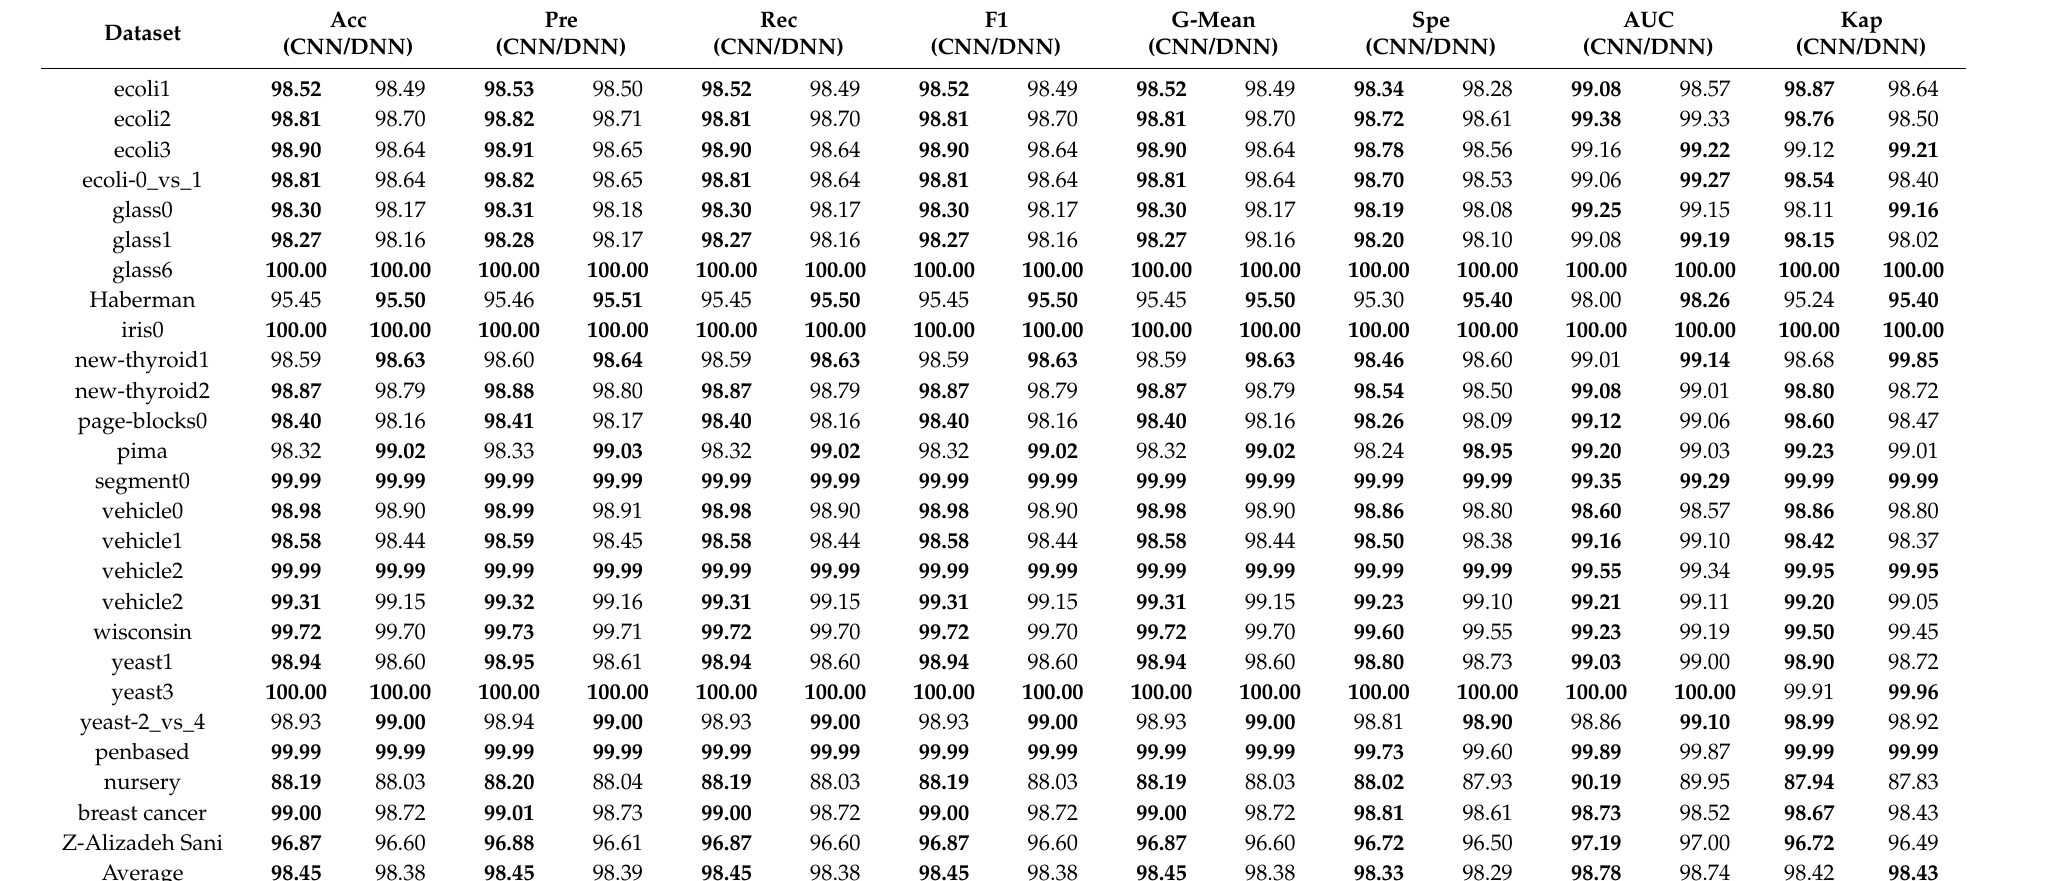
Table 10. ROS + NORM. +